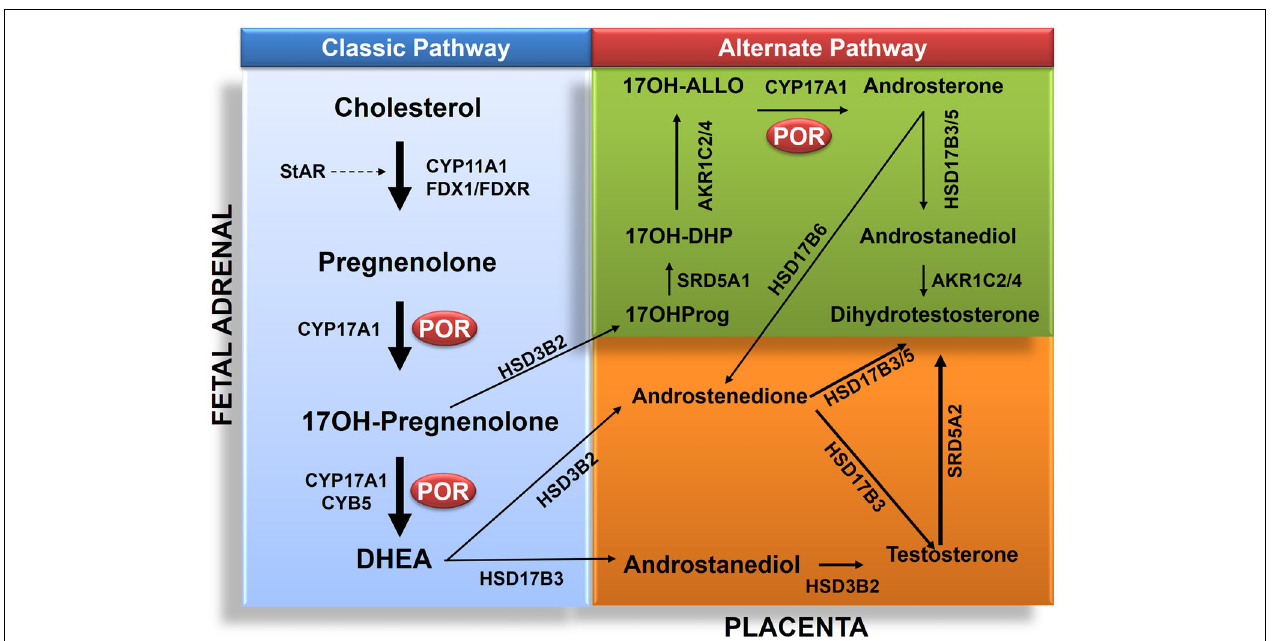
FIGURE 3 | Role of POR in biosynthesis of androgens in classic and alternate pathways. The classic pathway proceeds from transfer cholesterol to mitochondrion through steroidogenic acute regulatory protein (StAR). In the mitochondrion cholesterol is converted to pregnenolone by CYP11A1. The biosynthesis process then continues from pregnenolone to 17OHPreg and DHEA to androstenedione or androstenediol and then to testosterone in testicular Leydig cells. Testosterone (T) is converted to dihydrotesterone (DHT) in genital skin.